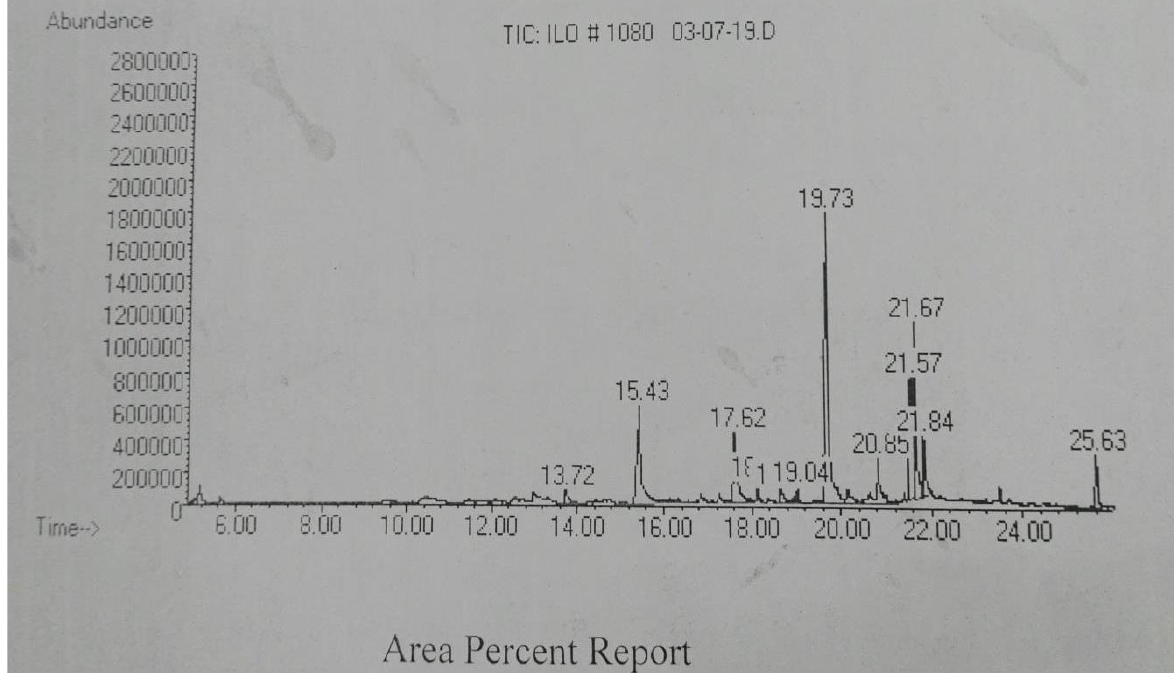
Figure 3. Chromatogram with chloroform extract of Datura metel